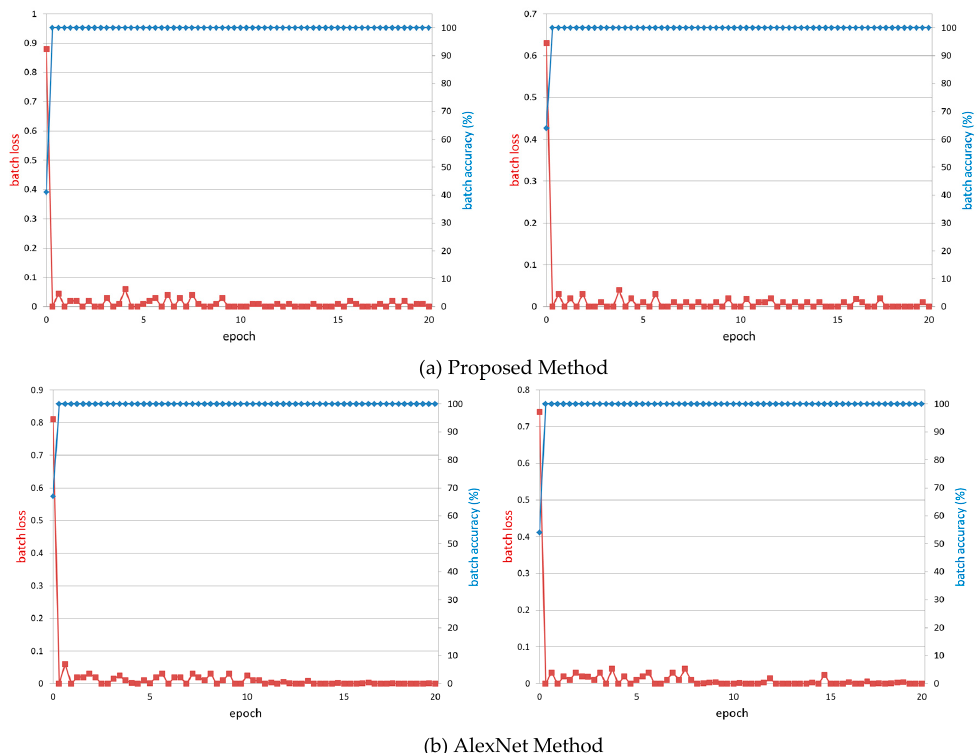
Table 5. Parameters used by our stochastic gradient descent (SGD) method.